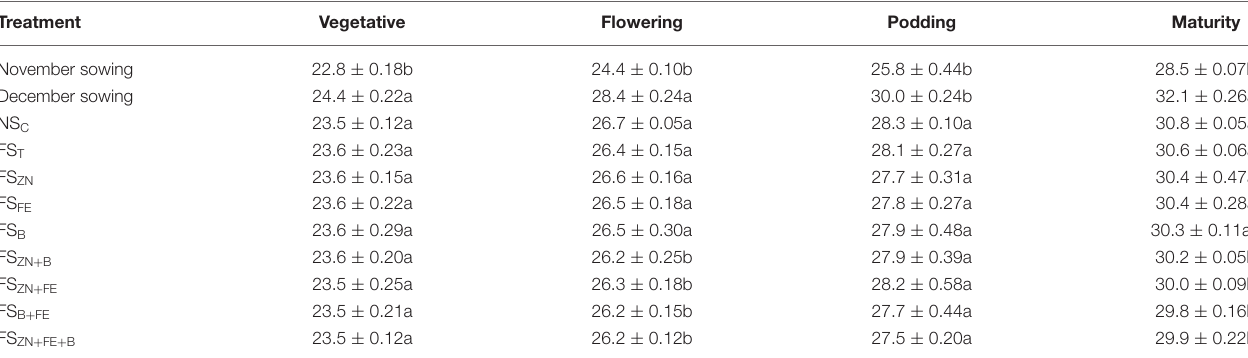
TABLE 4 | Canopy temperature of lentil influenced by date of sowing and foliar spray of micronutrients (pooled data of 2 years). Treatment Vegetative Flowering Podding